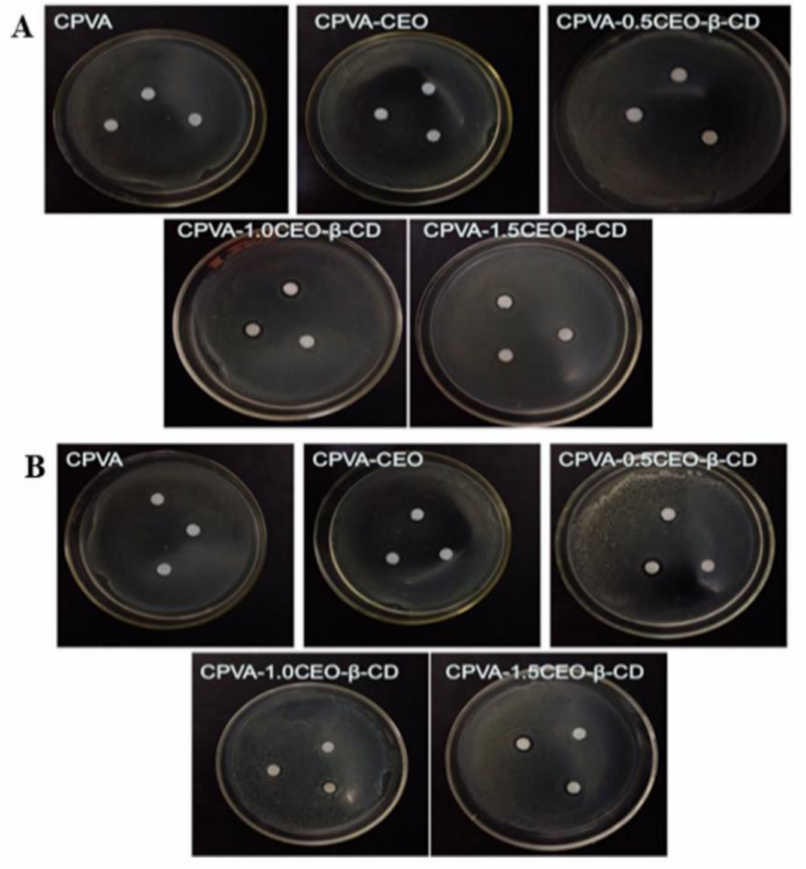
Figure 11. Antibacterial effect against ( A ) Escherichia coli and ( B ) Staphylococcus aureus by the nanofi- brous film. Adapted from [135] with the copyright permission of